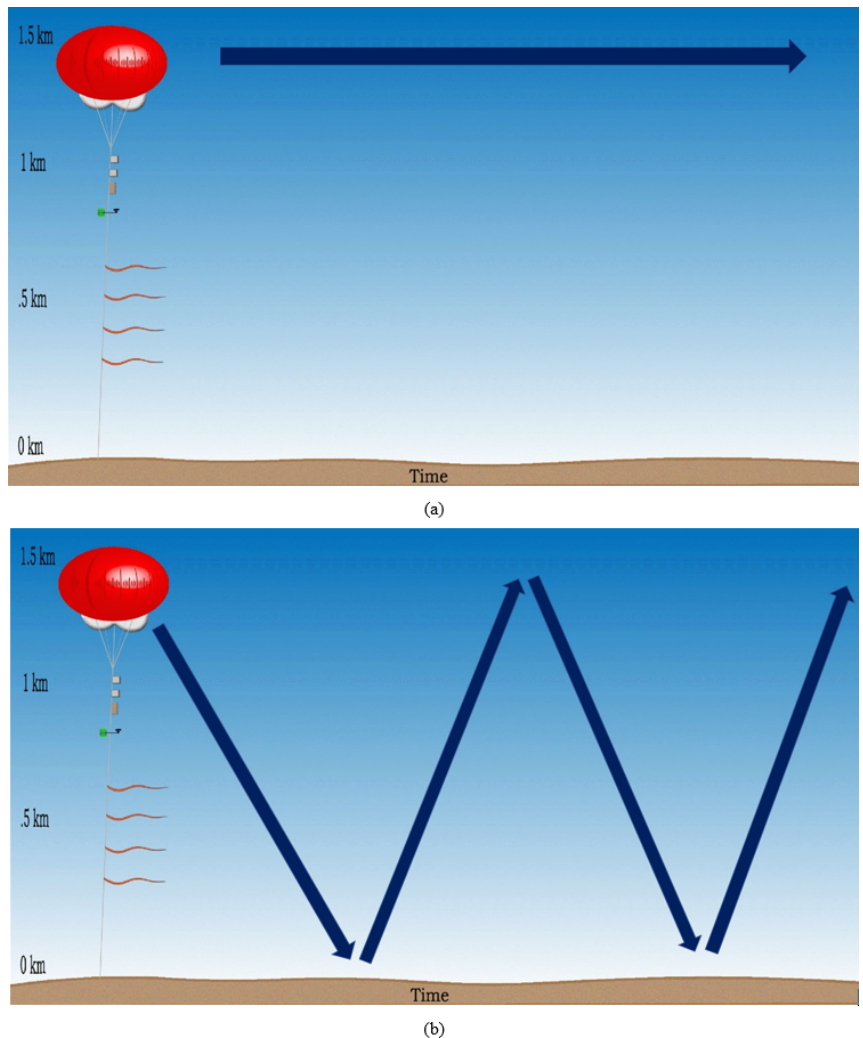
Figure 2. TBS typical flight pattern: (a) loitering flight and the balloon fixed at one altitude; (b) profiling flight and the balloon going up and down. The arrows indicate that the altitudes of the balloon remain during the